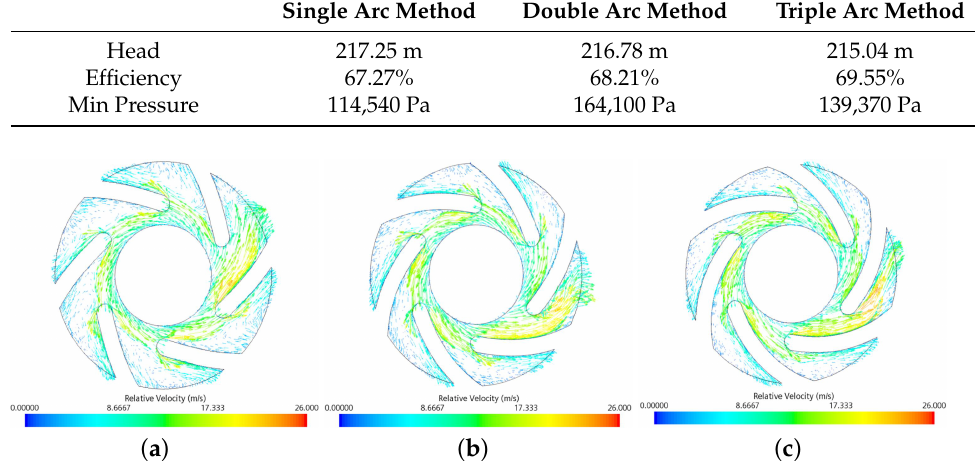
Figure 16. Velocity field for various impellers: ( a ) single arc method; ( b ) double arc method; ( c ) triple arc